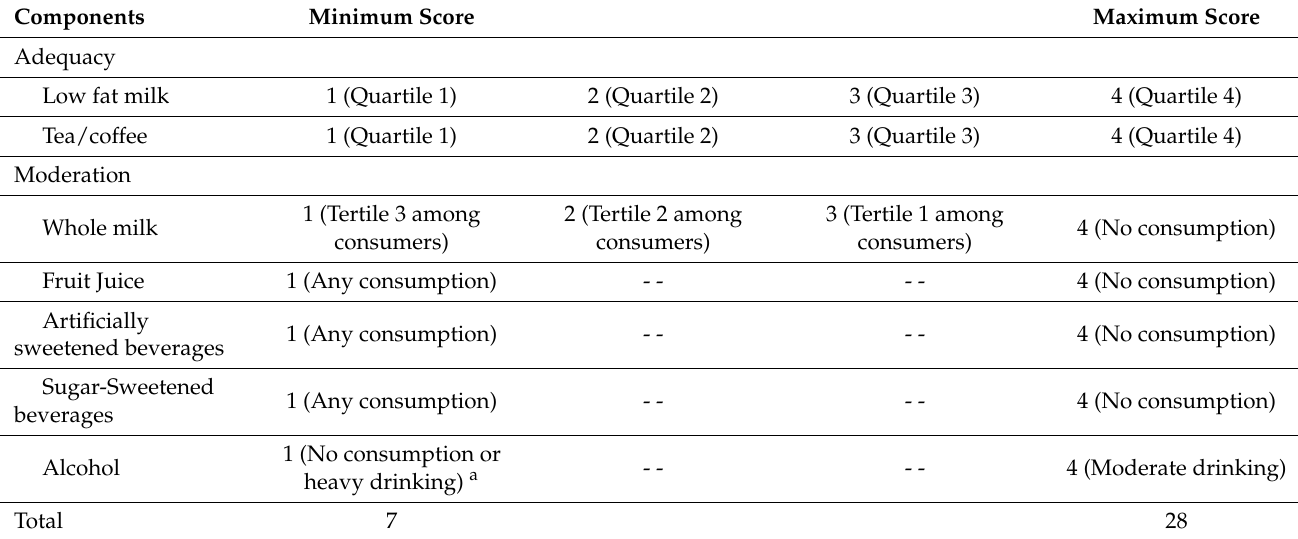
Table 1. Scoring criteria for the Healthy Beverage